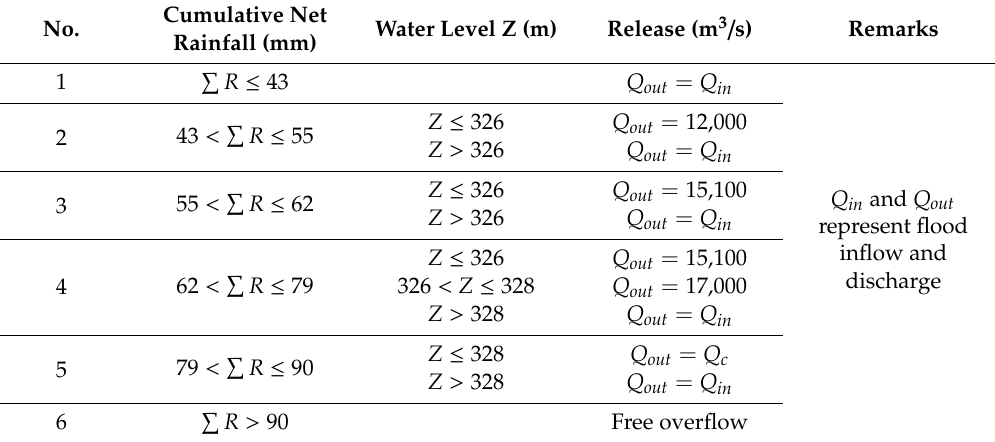
Table 2. Formulated FBO Rules for Ankang